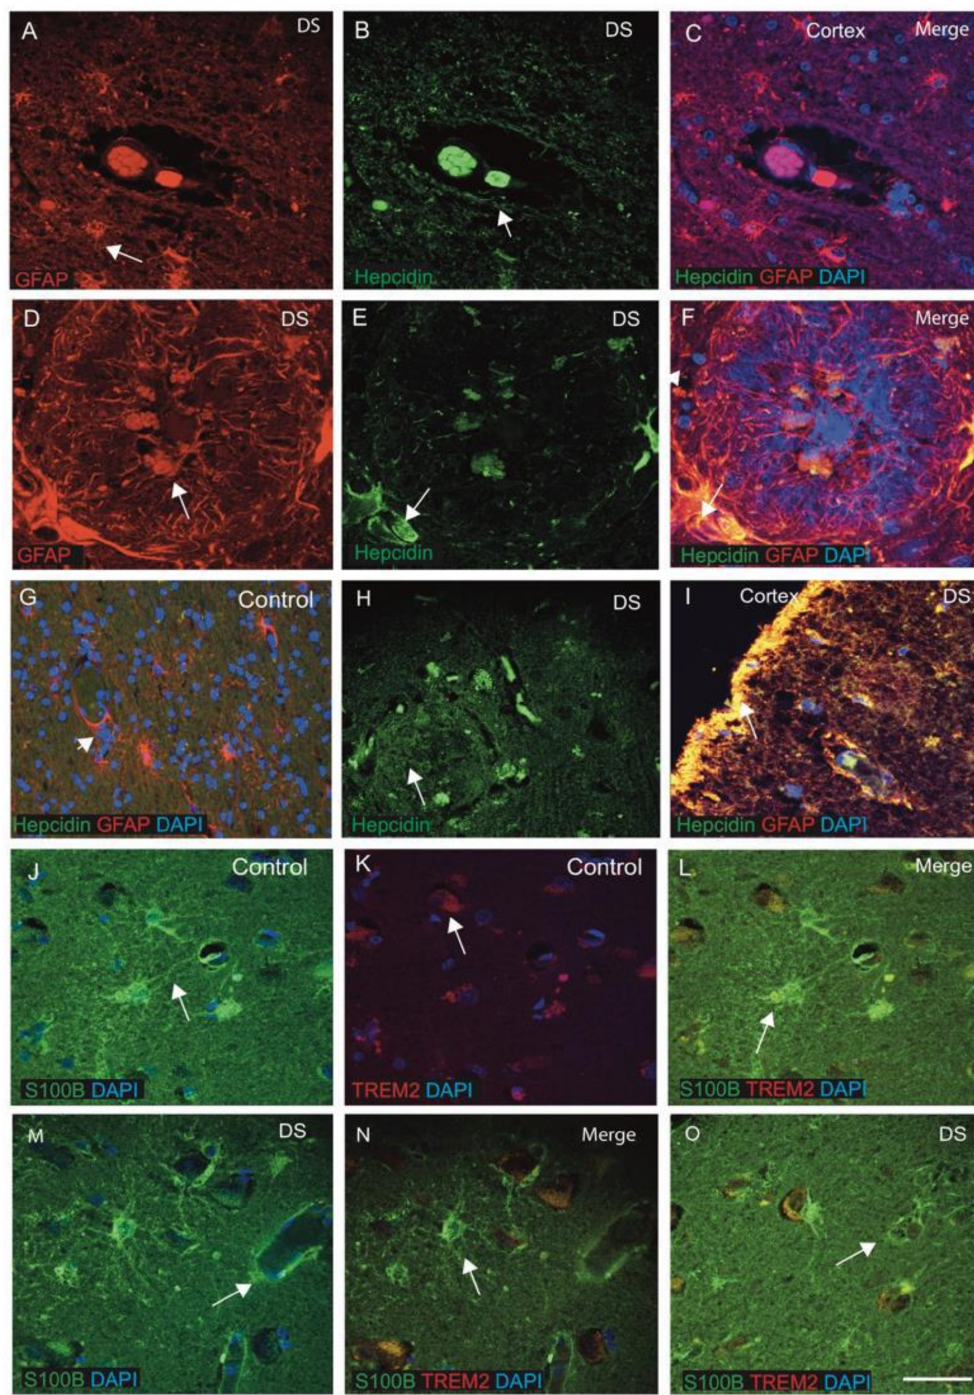
Figure 2. Hepcidin and S100 β -positive activated damaged astrocytes seen around the wall of blood vessels in DS. DS and control brain sections from the cortex and close to the blood vessels labelled with double immunofluorescence (IF) using anti-hepcidin (green), anti-GFAP (red), counterstained with DAPI for nuclei (blue) and imaged with confocal microscopy. In DS brain sections, GFAP-positive activated astrocytes were present around the SP and surrounding the blood vessels ( A – C , indicated with an arrow). Hepcidin expression was visible in the endothelial cells of blood vessels ( B ) and co-localised with the GFAP-positive astrocytes in the DS ( E , F ). In the senile plaques, GFAP-positive astrocytes were well-organised around the plaque formation ( D – F ). In the control brain section, normal astrocytes with fine processes were visible and co-localised with hepcidin in the cell bodies ( G ). A large number of small vesicles carrying hepcidin were present in the SP of the